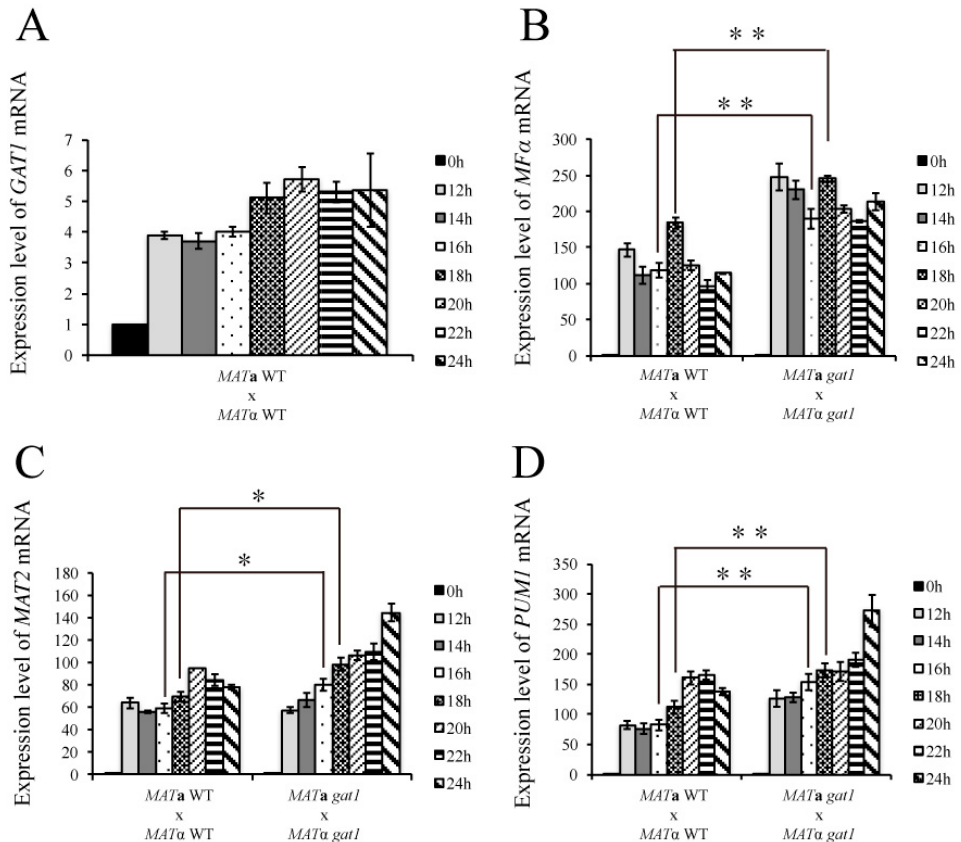
Figure 7. The expression of mating- and hyphal extension-related genes was increased in the bilateral gat1 mutant cross. Bilateral crosses involved the MAT a and MAT α wild-type and gat1 mutants were conducted on V8 agar plates and incubated at 26 ◦ C in the dark. Samples were collected at 0, 12, 14, 16, 18, 20, 22 and 24 h post-incubation. The expression of GAT1 ( A ), MF α ( B ), MAT2 ( C ), and PUM1 ( D ) was examined by real-time qRT-PCR analysis. Error bar represents the standard deviation from the mean of three replicates.Triplicate reactions for each sample were conducted. The results were normalized to C. neoformans GPD1 expression. (** indicates p < 0.005; * indicates p < 0.05).